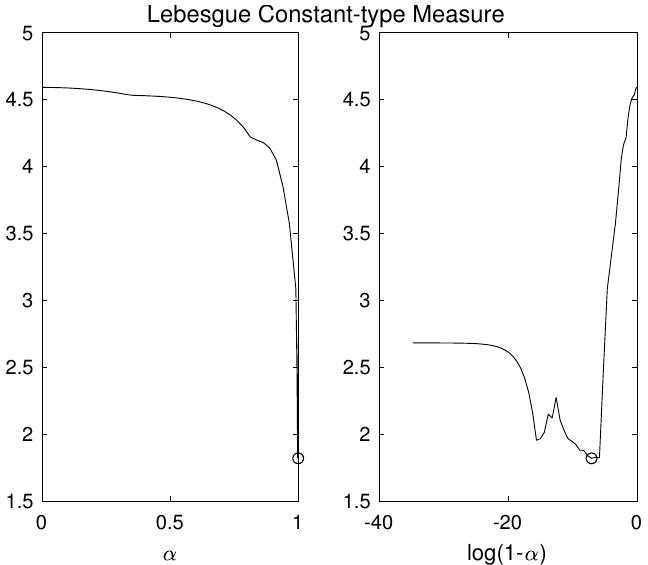
Figure 7. Lebesgue constant for the IKTE mapped points using a 37-point stencil with polynomials up to degree p = 15. The optimal α is